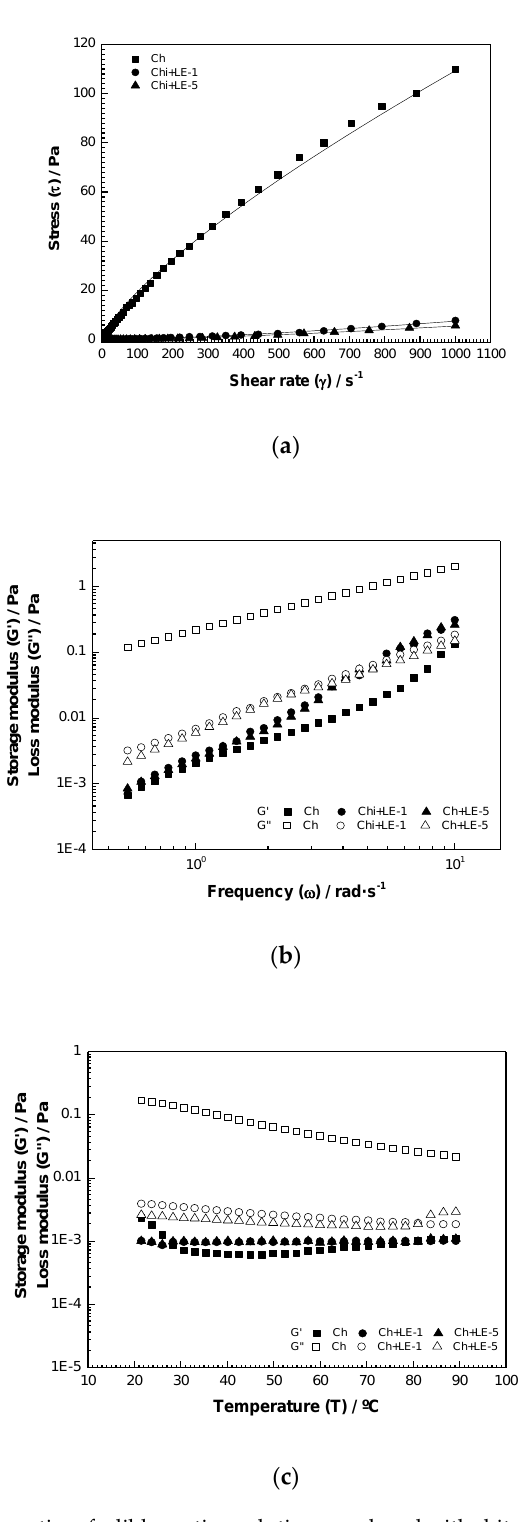
Figure 3. Rheological properties of edible coating solutions produced with chitosan and chitosan- Figure3. Rheologicalpropertiesofediblecoatingsolutionsproducedwithchitosanandchitosan-licorice: licorice: ( a ) flow curve, ( b ) frequency sweep and ( c ) temperature sweep. ( a ) flow curve, ( b ) frequency sweep and ( c ) temperature